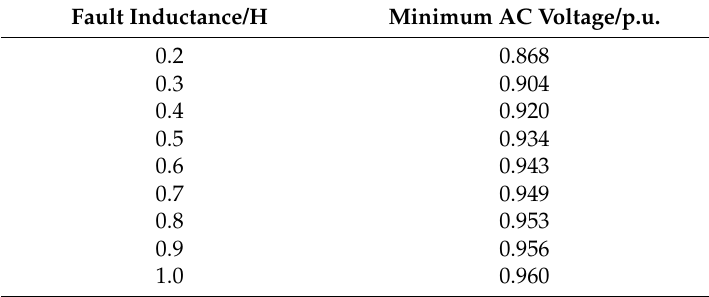
Table 2. The minimum AC voltage RMS values during the single phase to ground fault period.